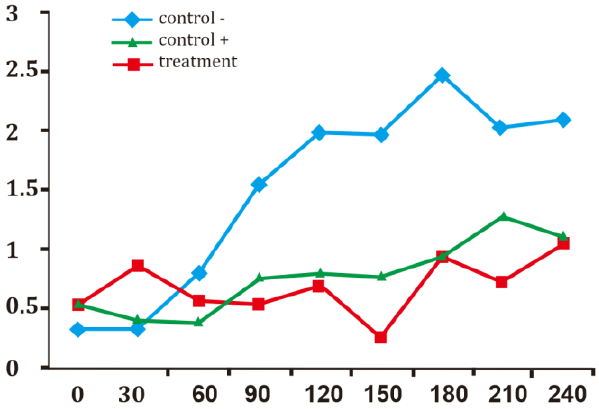
Figure 13. Edema (ml) vs t (hours), the anti-inflammatory effect of the positive control ibuprofen (200 mg/kgBW) and treatment with the compound 1-(2,5-dihydroxyphenyl)-(3-pyridine-2-yl)-propenone (200 mg/kgBW).